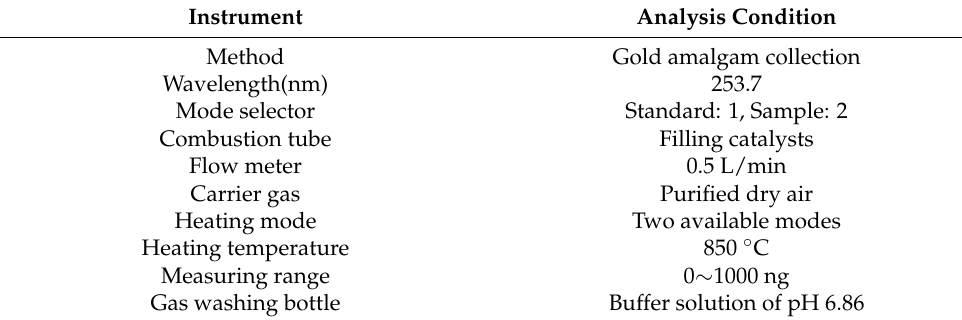
Table 2. Analysis conditions of automatic mercury analyzer.